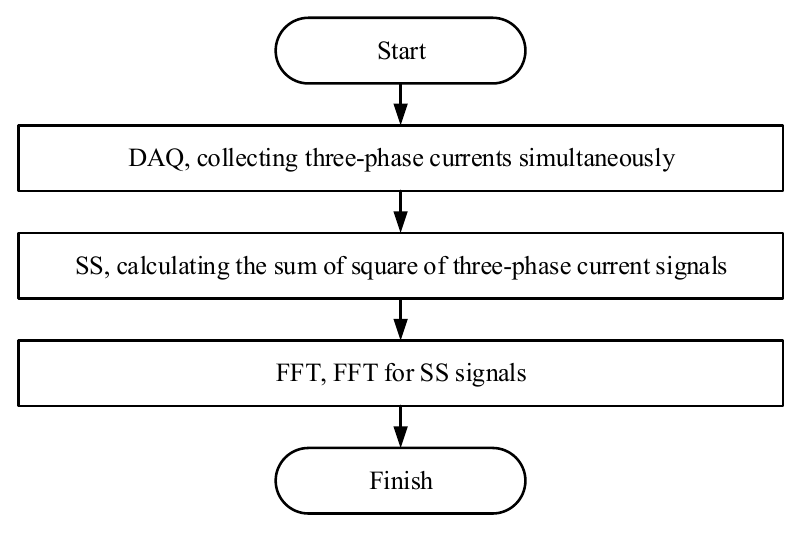
Figure 1. Flow chart of the Sum-of-Squares (SS) method.